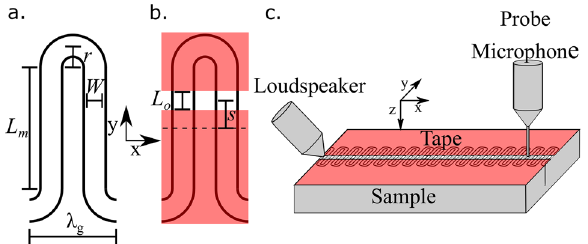
Figure 1. ( a ) Schematic of the unit cell of the uncovered meander structure used. This consists of a single continuous air filled channel surrounded by an assumed perfectly rigid material. ( b ) Schematic of the covered meander structure. The underlying structure is the same except the unit cell has been partially covered (red regions) leaving a small uncovered region with centre shifted a distance s from the centre of the structure. Both structures extend into the page a depth d . ( c ) Experimental setup. A loud speaker emits a pulse of sound that excites an acoustic surface wave. A probe microphone scans over the surface detecting the signal.